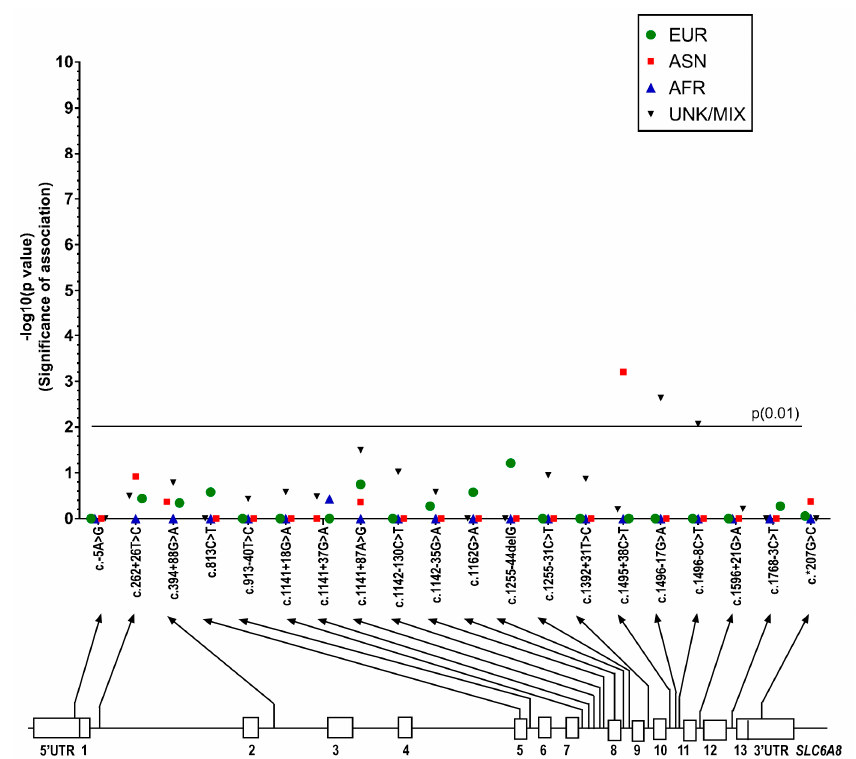
Figure 6. Manhattan plot showing the p -values from Fisher’s exact test (significance of association, plotted as -log (p)) for each SNP sequenced on the solute carrier family 6 member 8 ( SLC6A8) gene. p -values are shown for European, East Asian, African, and Unknown/Admixed populations. The nominal statistical threshold for p = 0.01 is shown. The location of each SNP is shown on the SLC6A8 gene below the x -axis. EUR: European; ASN: East Asian; AFR: African; UNK/MIX: Unknown/Admixed populations.